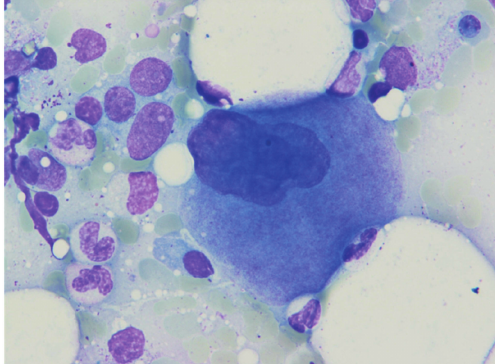
Figure 2: Axial CT scan of the chest, lung window: dense consolida- tion in the posterior aspect of the right lung. A few other smaller in- filtrations are also seen in the left lung in this region. FNA is taken from right side.